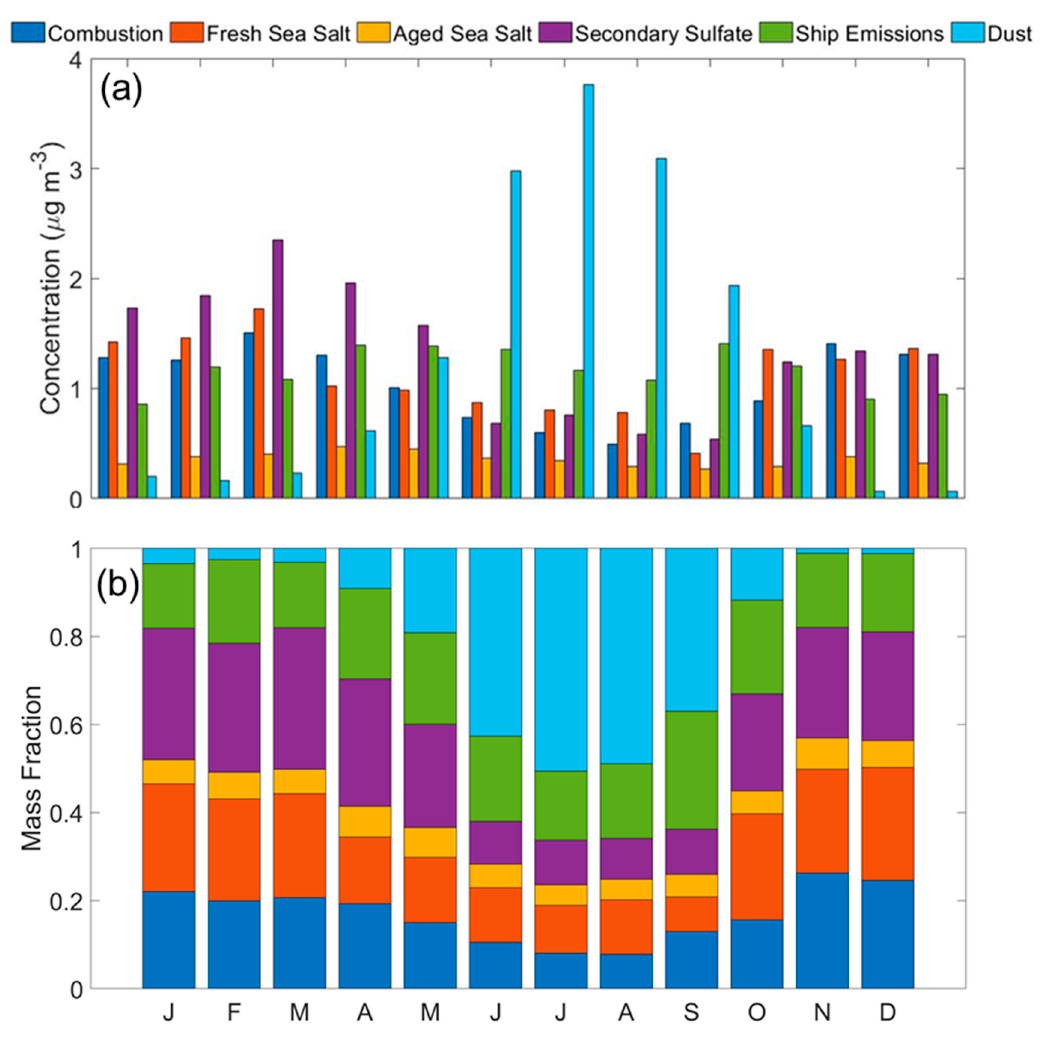
Figure 5. ( a ) Monthly mean aerosol concentrations and ( b ) fractional contribution for each of the six PMF source factors.